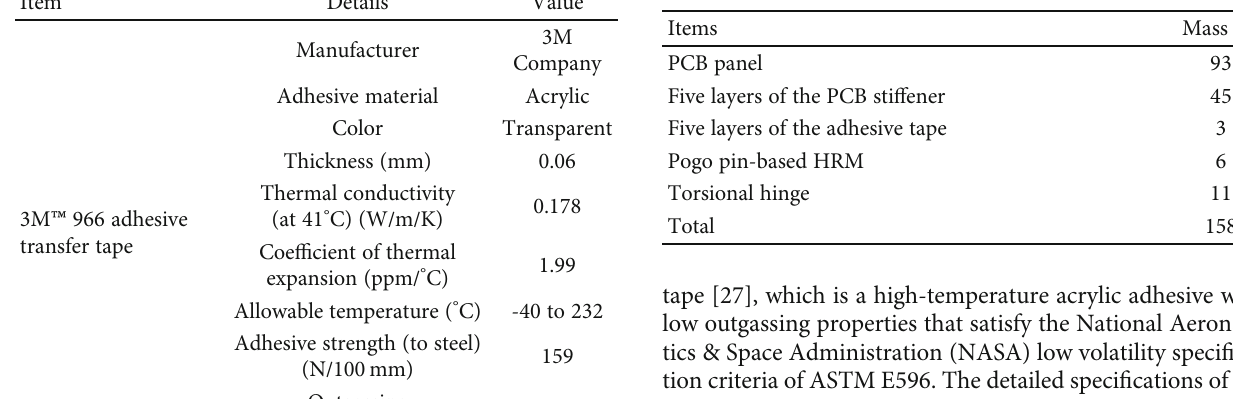
Table 2: Mass budget of the demonstration model of the 3 U solar panel